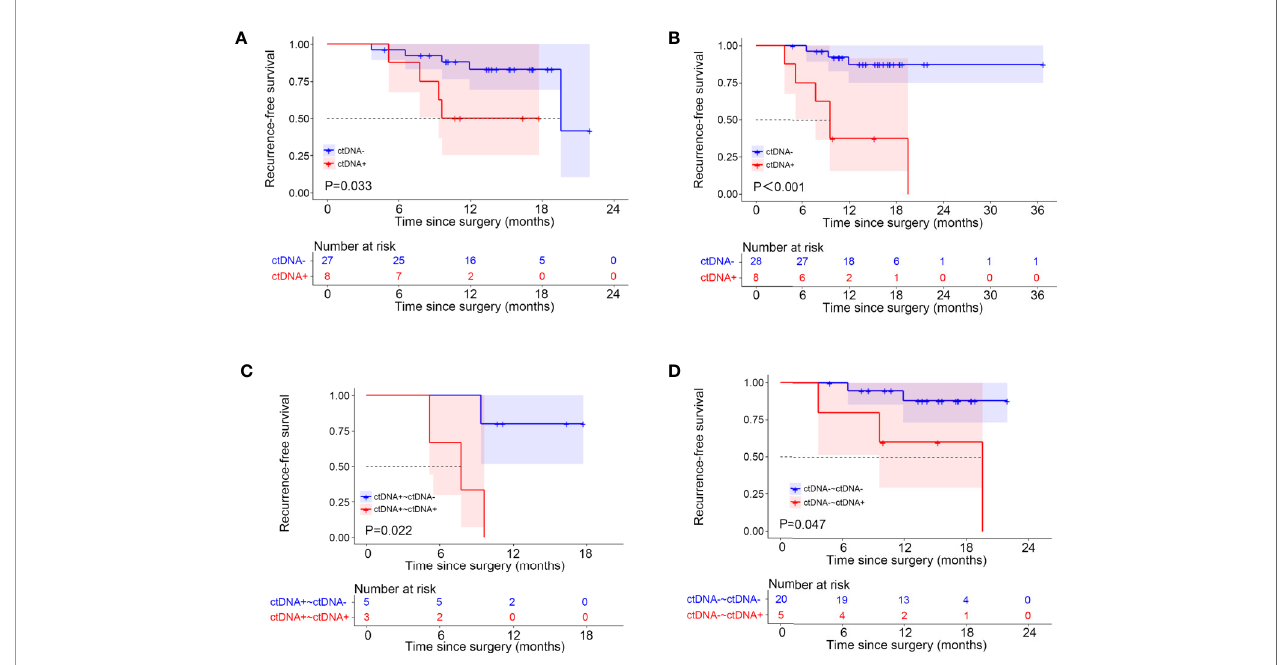
FIGURE 4 | Kaplan-Meier estimates of recurrence-free survival according to circulating tumor DNA (ctDNA) status. (A) postoperative ctDNA; (B) post-chemotherapy ctDNA; (C) postoperative positive ctDNA; (D) postoperative negative ctDNA.